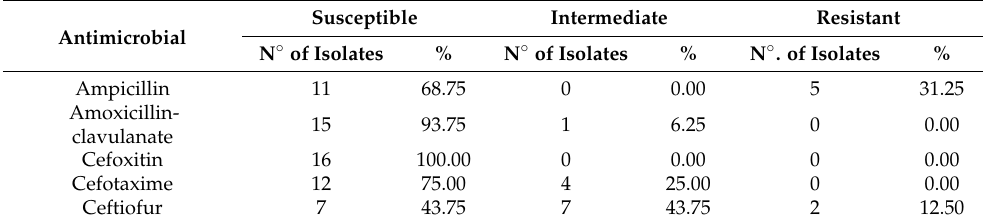
Table 5. Results of disk diffusion test for Salmonella spp.